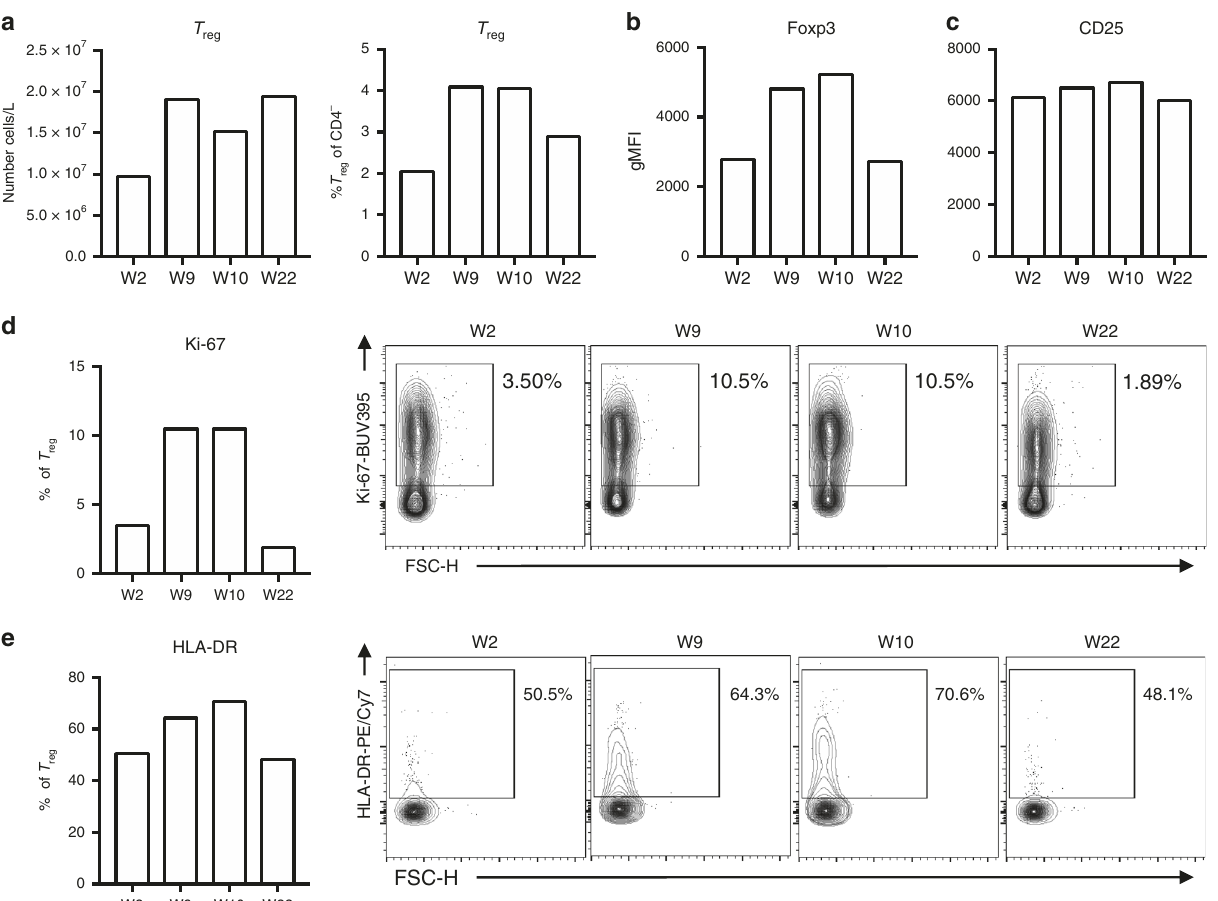
Fig. 4 Increased T reg cell numbers were maintained in peripheral blood under ICI-mTORi therapy ( a ) T reg cell (CD3 + CD4 + CD25 High CD127 Low Foxp3 + Helios + ) numbers and proportions from total CD4 + T cells in blood are plotted as was determined with fl ow cytometry. ( b , c ) Geometric mean + ) and ( e ) activated (HLA-DR + ) fl uorescence intensity (gMFI) of ( b ) Foxp3 and (C) CD25 on T reg cells are shown. ( d , e ) Proportions of ( d ) cycling (Ki-67 cells of T reg cells are shown with the representative fl ow cytometry plots on the right. Flow cytometric analyses were completed